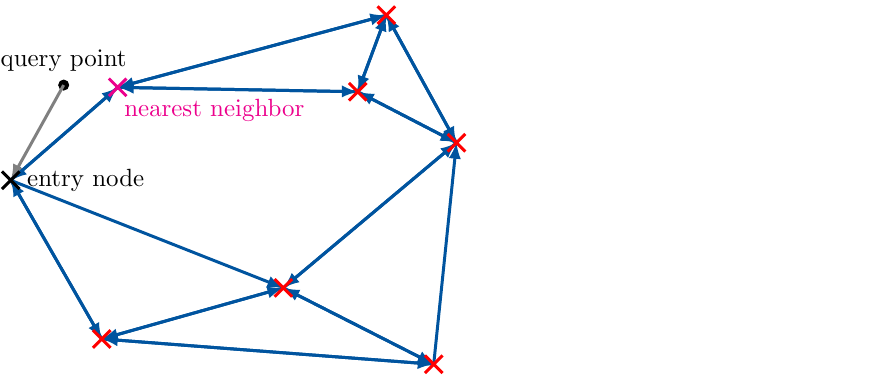
markers correspond to the parameters ×